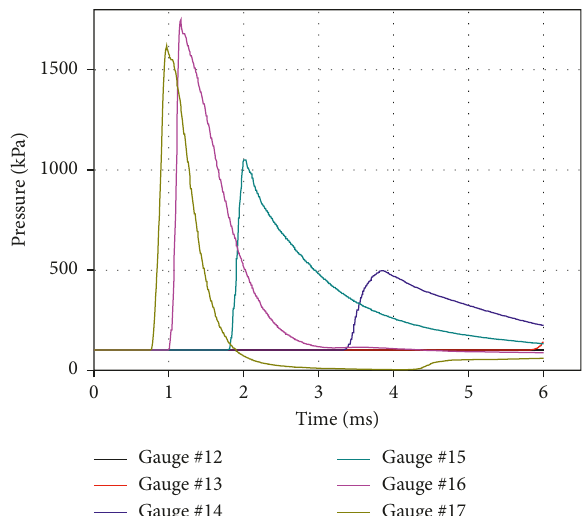
Figure 8: Pressure-time history of Gauges.